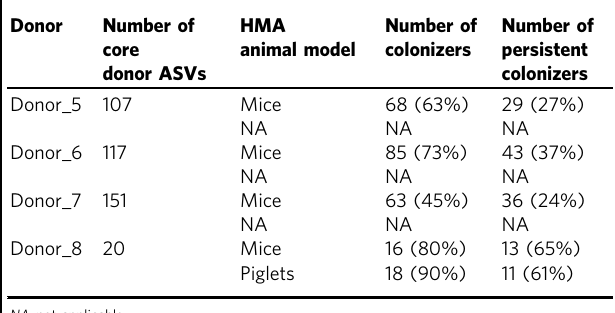
Table 2 Summary of establishment of core donor ASVs in HMA animal models transplanted with a second set of